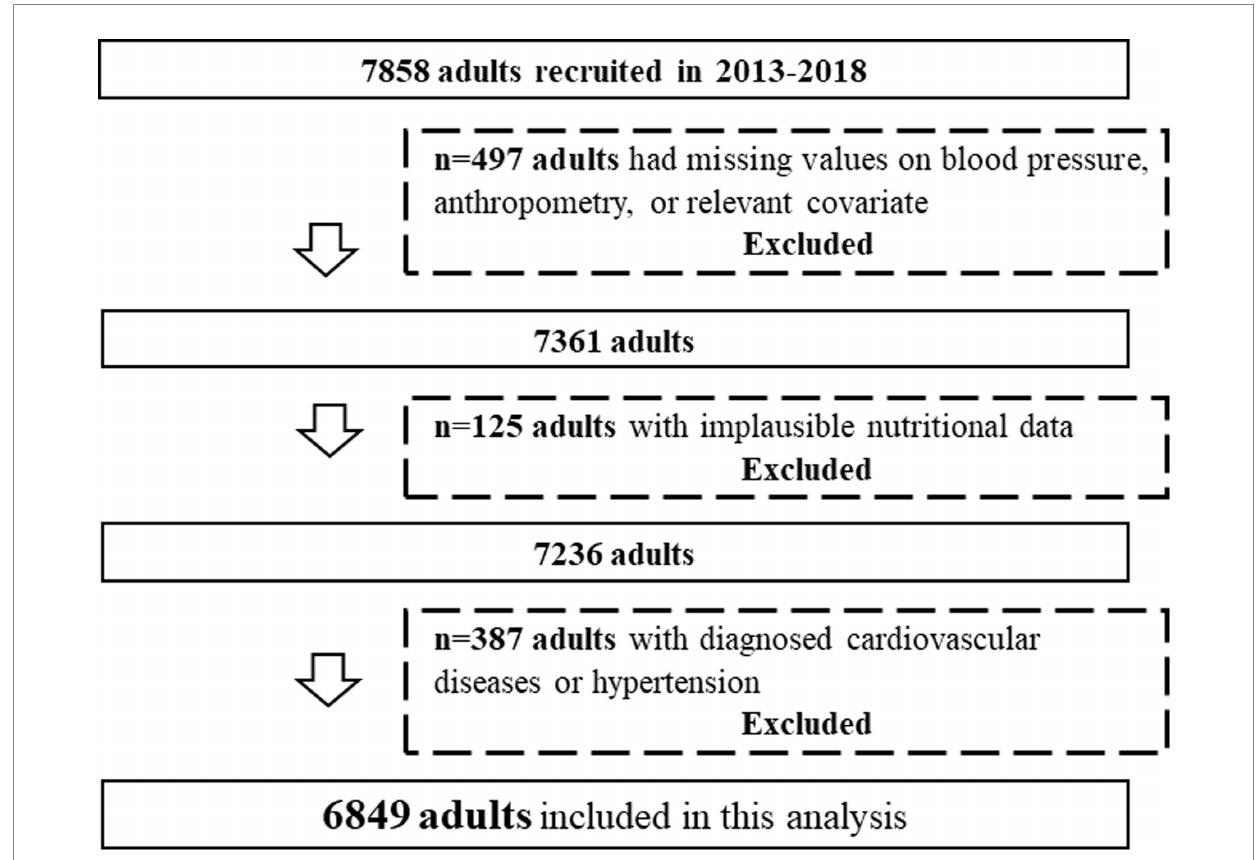
FIGURE 1 Flowchart for the study